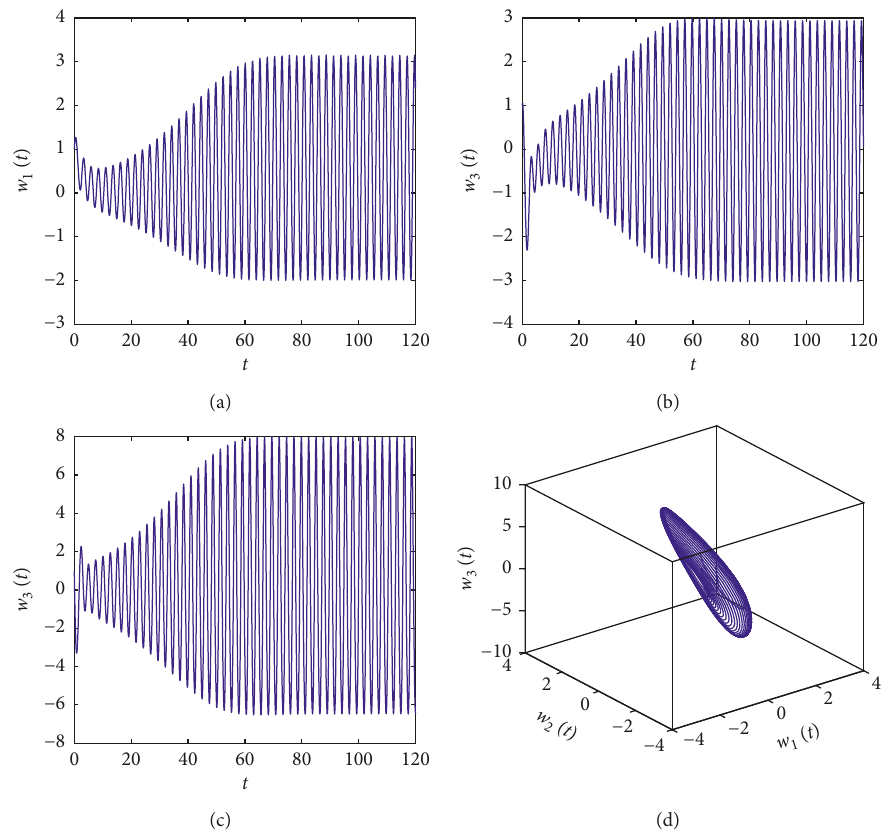
Figure 4: Computer simulations of model (69) when 9